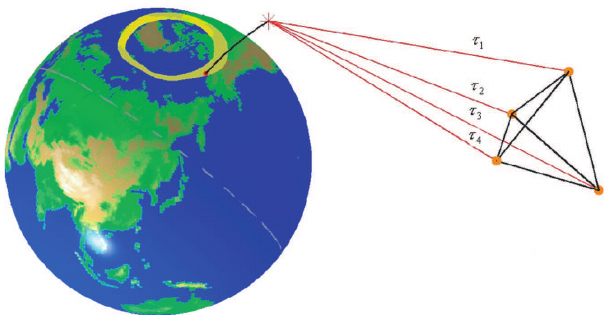
Fig. 1. Geometry of AKR source location algorithm using a 4- element VLBI array. The source location is found using geomet- ric delays τ j which are determined using the observed differential delays τ ij and Eq.